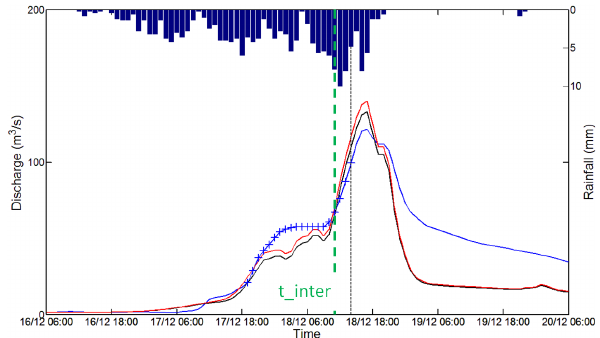
Fig. 6. Data assimilation results for the December 1997 event. The blue curve corresponds to observations; the black curve is the background simulated hydrograph (before assimilation), and the red curve is the simulated analysis hydrograph (after assimilation). Blue crosses represent the assimilated data points.